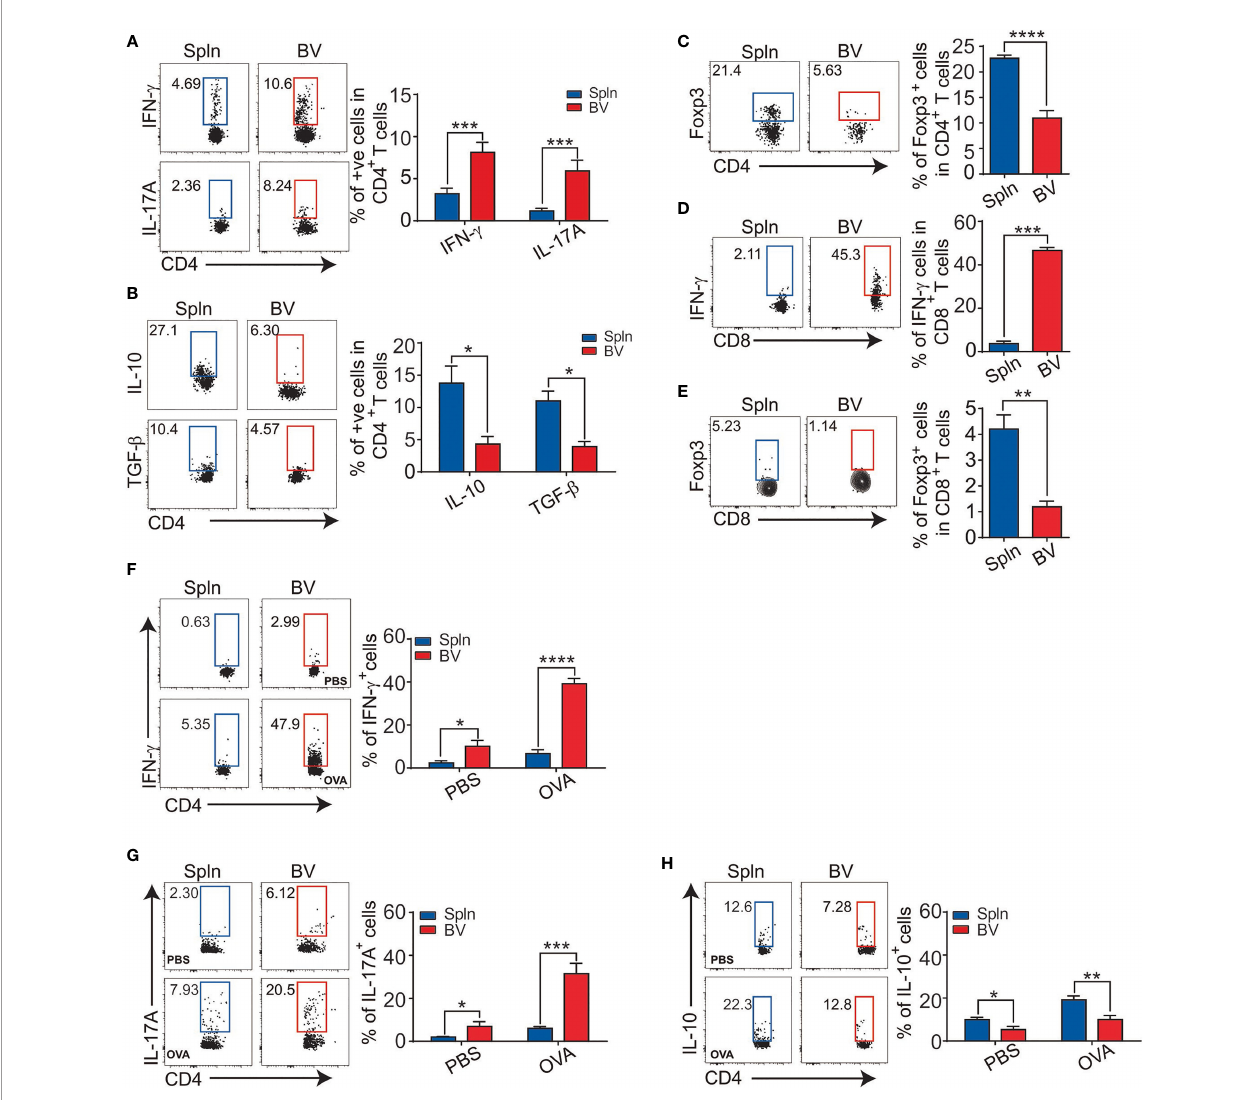
FIGURE 7 | T-cell differentiation in vascular tissues during in fl ammation. Mice were injected with LPS before their BV and Spln were extracted to analyze the expression of IFN- g , IL-17A (A) , IL-10, TGF- b 1 (B) , and Foxp3 (C) in CD4 + T cells and IFN- g (D) and Foxp3 (E) in CD8 + T cells. Alternatively, OT-II mice were injected with 200 µg OVA or PBS/LPS with LPS for 72 h before FACS analysis of indicated cytokines in CD4 + T cells (F – H) . Shown here are representative plots of experiments with at least two biological replicates. The data are shown as mean ± SEM ( n = 2 – 16 mice) and analyzed using Student ’ s t -test. * p < 0.05; ** p < 0.01; *** p < 0.001; **** p <